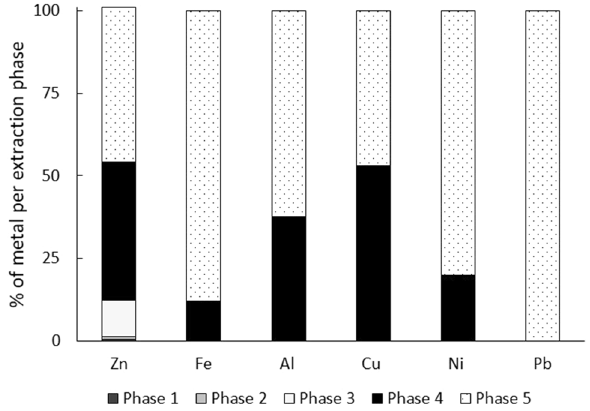
Figure 3. Percentage of metal in each extraction phase in the sediments from the urban sinkholes in this study. Phase 1—Water soluble; Phase 2—Exchangeable; Phase 3—Carbonate bound; Phase 4—Organic matter bound; Phase 5—Residual.